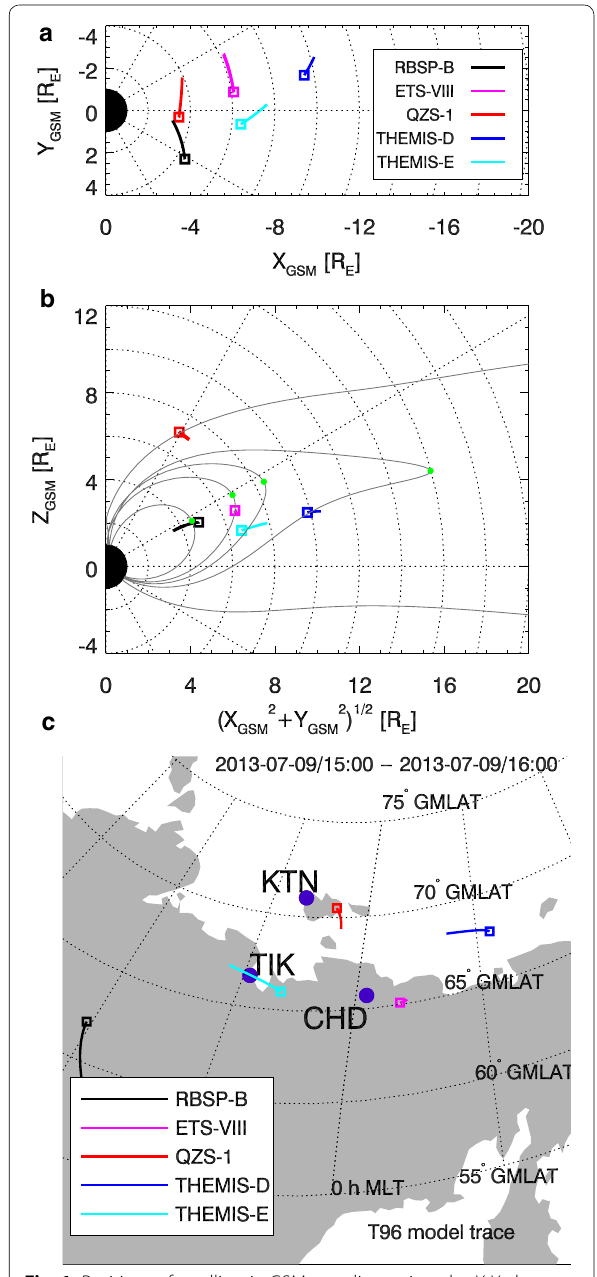
Fig. 1 Positions of satellites in GSM coordinates in a the X - Y plane and b the meridional plane during 15:00–16:00 UT on July 9, 2013. The magnetic field line is estimated by the Tsyganenko 96 model at 15:15 UT, and the green dot is the magnetic equator on the field line. c Positions of ionospheric footprints of satellites and ground magnetic observatories during 15:00–16:00 UT on July 9, 2013. The ionospheric footprints are estimated by the Tsyganenko 96 model with fixed parameter obtained from solar wind data and SYM-H index at 15:15 UT. The grids show AACGM geomagnetic latitude and magnetic local time. The local time grids are calculated at 15:15 UT and spaced by an